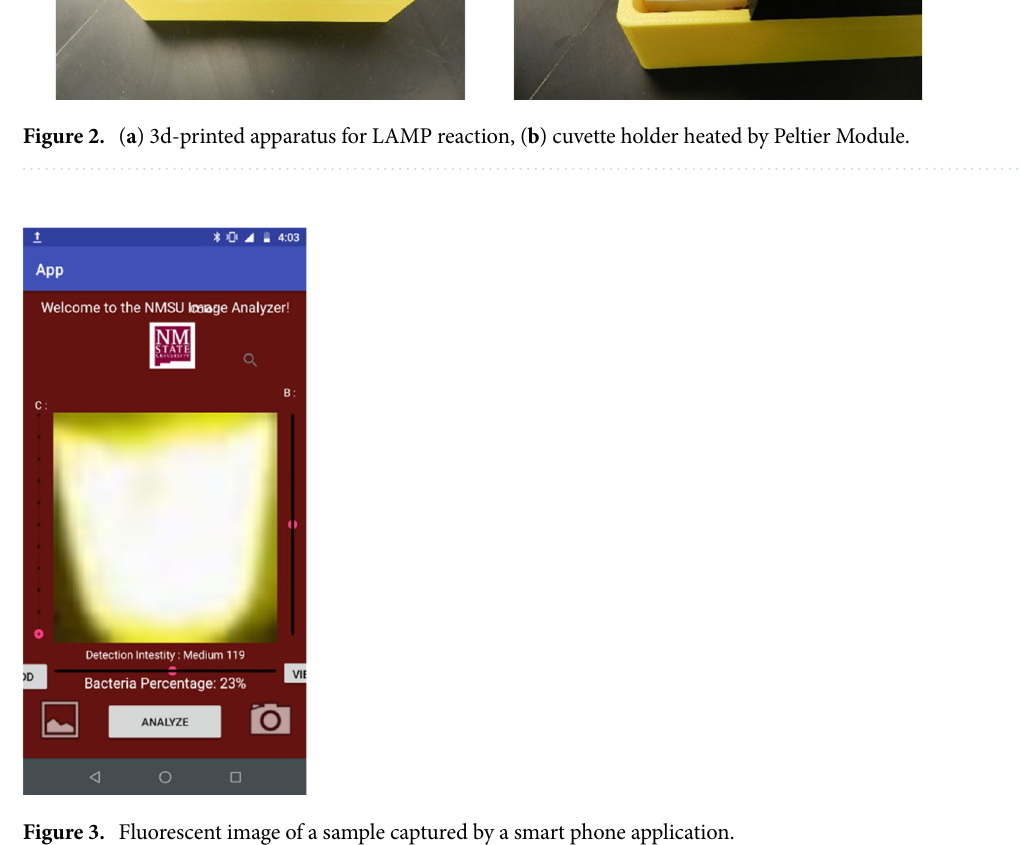
Figure 3. Fluorescent image of a sample captured by a smart phone